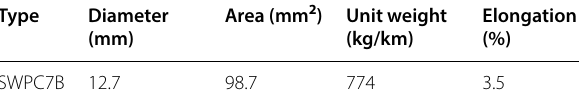
Table 2 Material properties of strands.